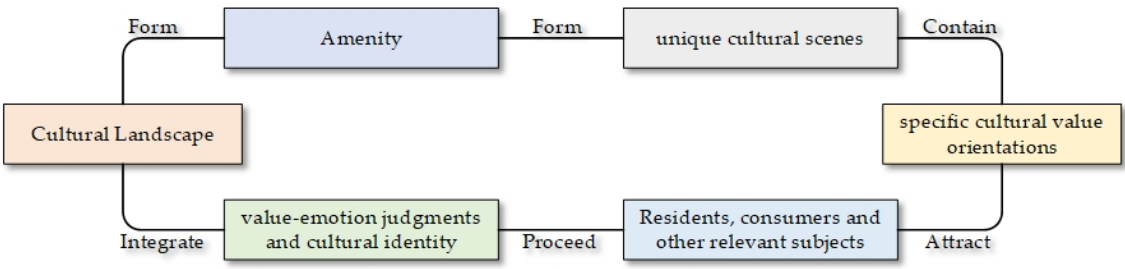
Figure 2. The connection between scene theory and cultural landscape.